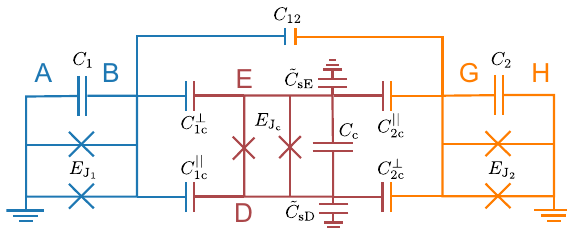
FIG. 6. The derivation of the effective model using star-mesh transformations. The capacitances are defined in Eqs. (A3) and (A4).